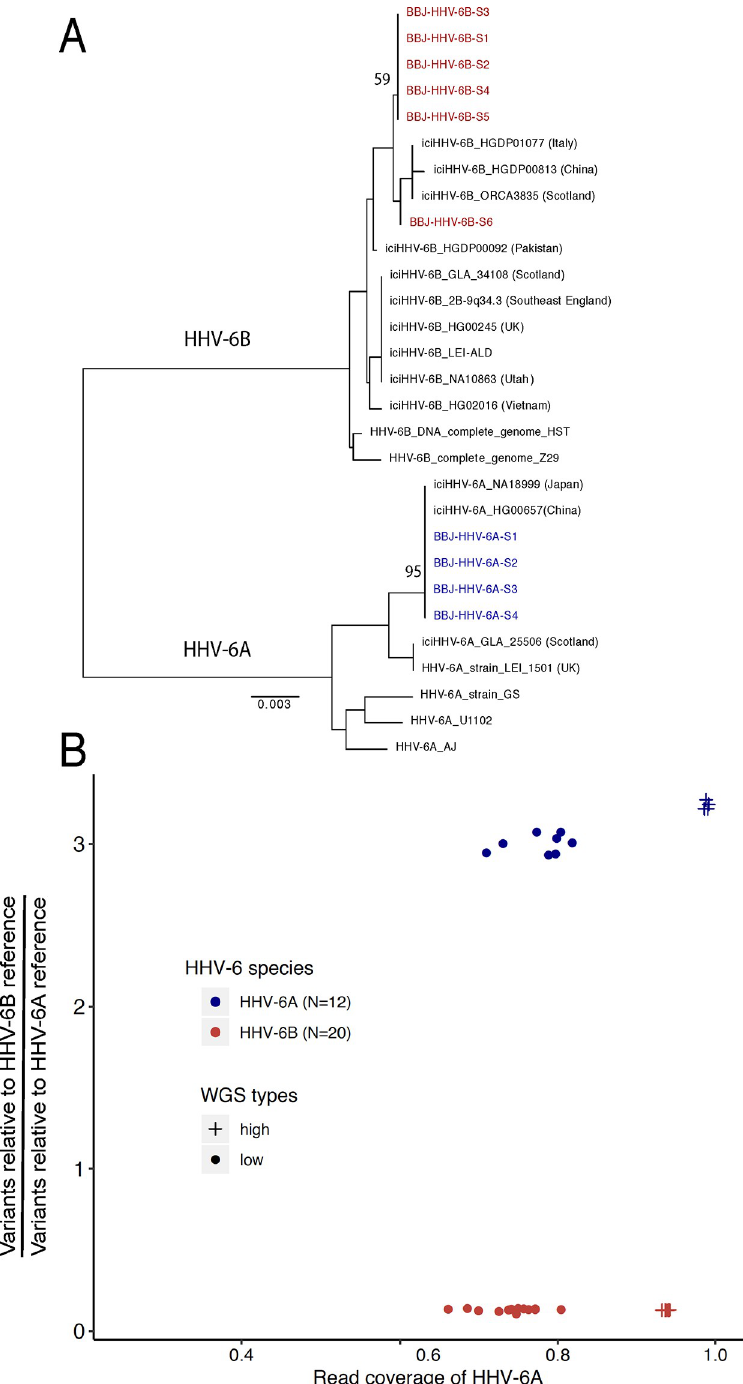
Fig 3. HHV-6 species is readily distinguished in subjects with both high- and low-depth WGS A) Neighbor- joining phylogenetic tree of concatenated HHV-6 viral genes U27/U43/U87 from 29 HHV-6 genomes. HHV-6A sequences from high-depth WGS samples from BioBank Japan (BBJ), colored in blue, are monophyletic and are identical to integrated HHV-6A sequences of Japanese (NA18999) and Chinese (HG00657) subjects from 1kGP. HHV-6B sequences obtained from BBJ subjects are labelled in red. Bootstrap value per 100 replicates of selected nodes is shown. The scale bar represents 0.003 substitutions per site. B) Comparing variants and mapping coverage relative to HHV-6A and HHV-6B reference genomes distinguishes species for subjects with low-depth WGS. The Y axis indicates the ratio of variants called in comparison to the HHV-6B reference versus those called in comparison to